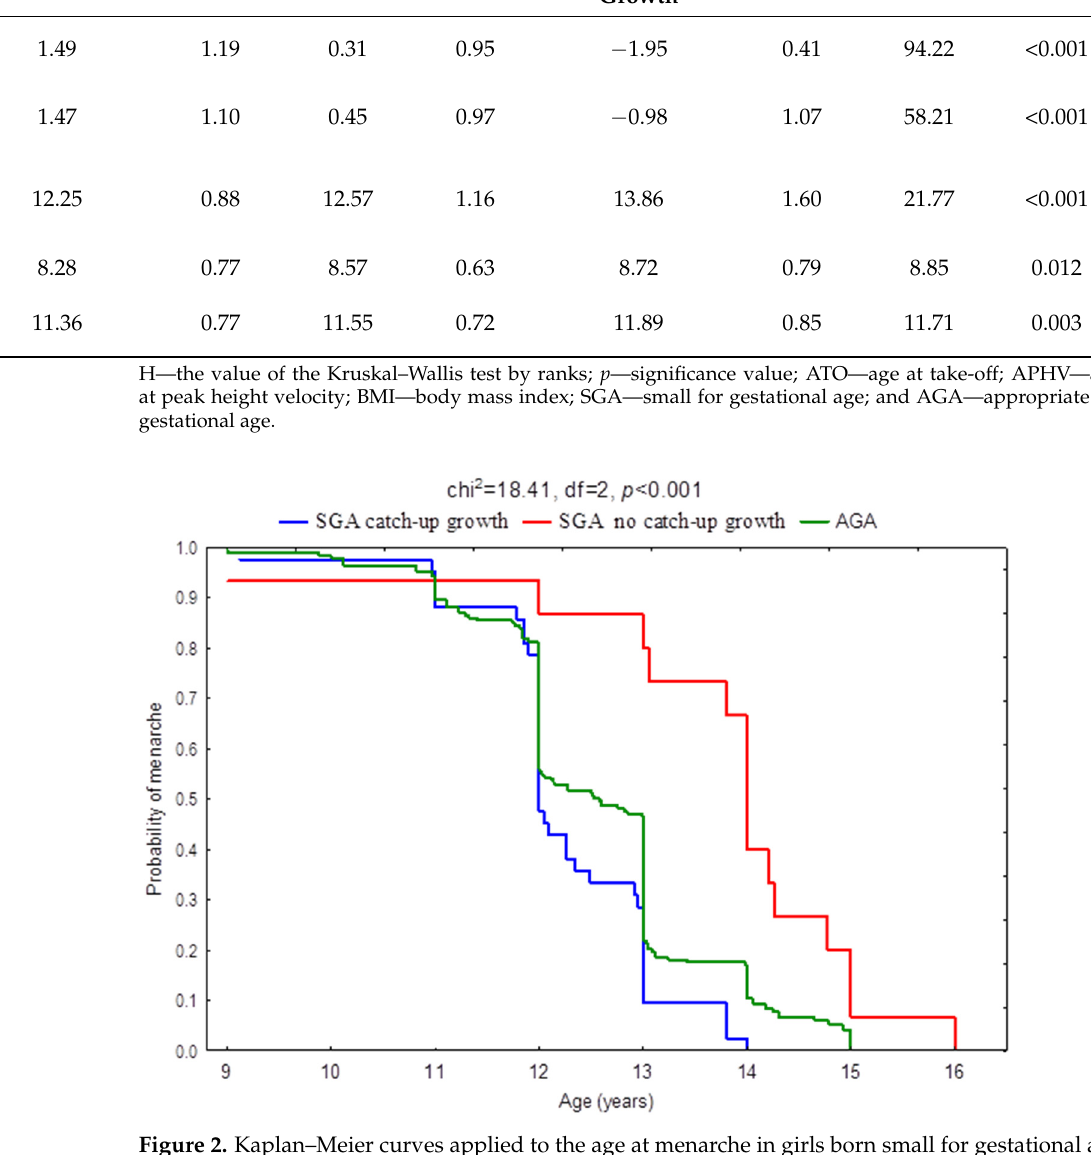
Table 2. Mean values of BMI at 8 ya and at menarche, age at menarche, and age at TO and PVH in categories of birth size and catch-up growth of the studied girls.